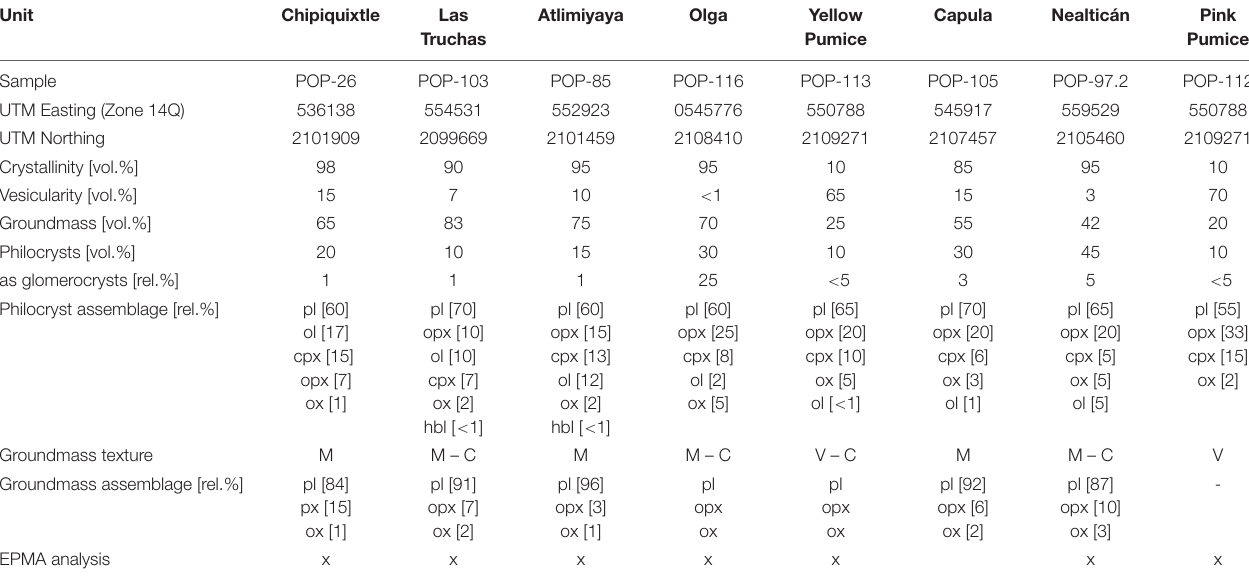
Atlimiyaya Olga Yellow Capula Nealticán Pink Truchas Pumice Pumice